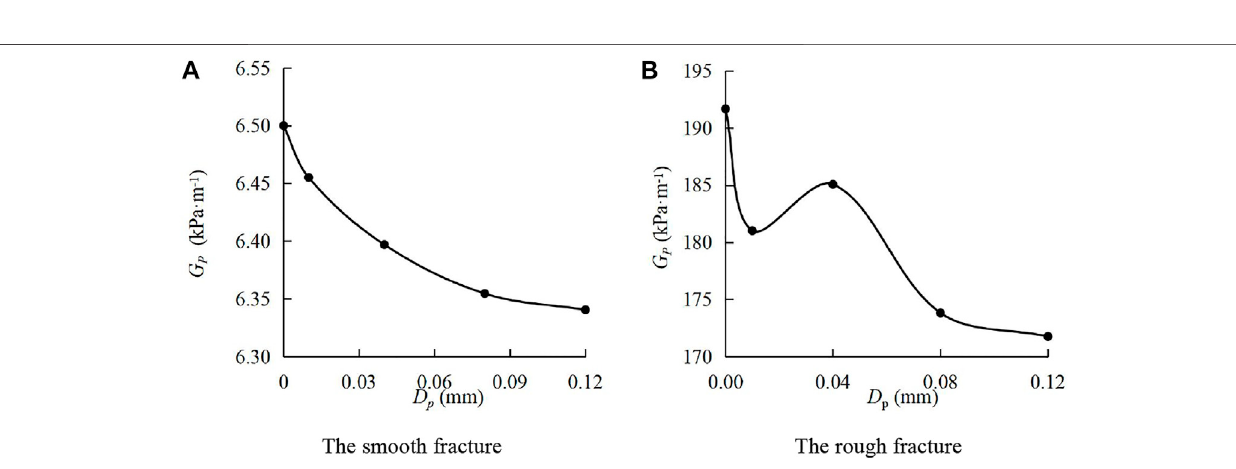
Frontiers in Physics |